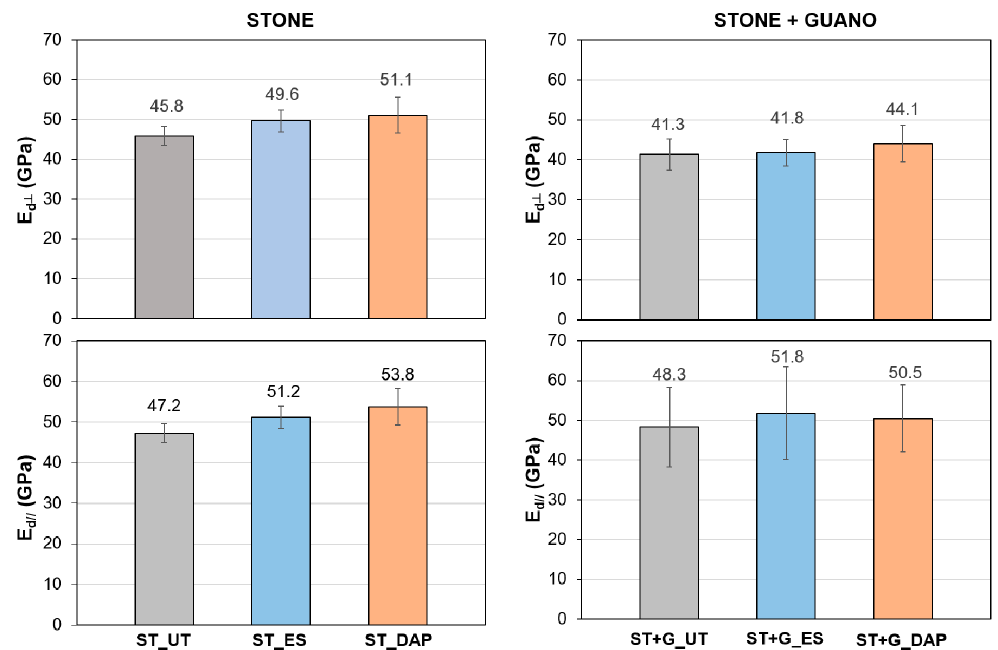
Figure 7. Dynamic elastic modulus ( E d ) of untreated (“UT”) and treated (“ES” and “DAP”) stone (“ST”) and stone+guano (“ST+G”) specimens in the directions perpendicular and parallel to the plane of the slab.